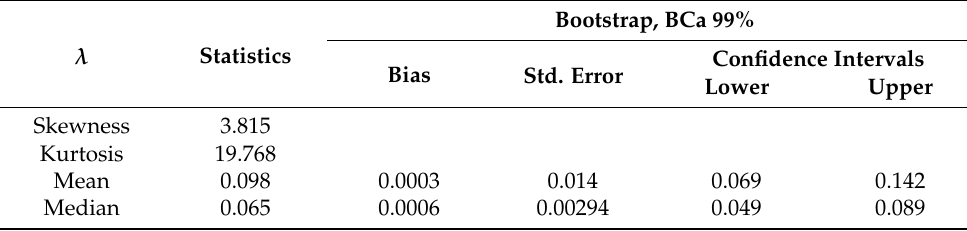
Table 1. Inferential statistics results of derived λ for M70 decadal dataset at α = 0.01.